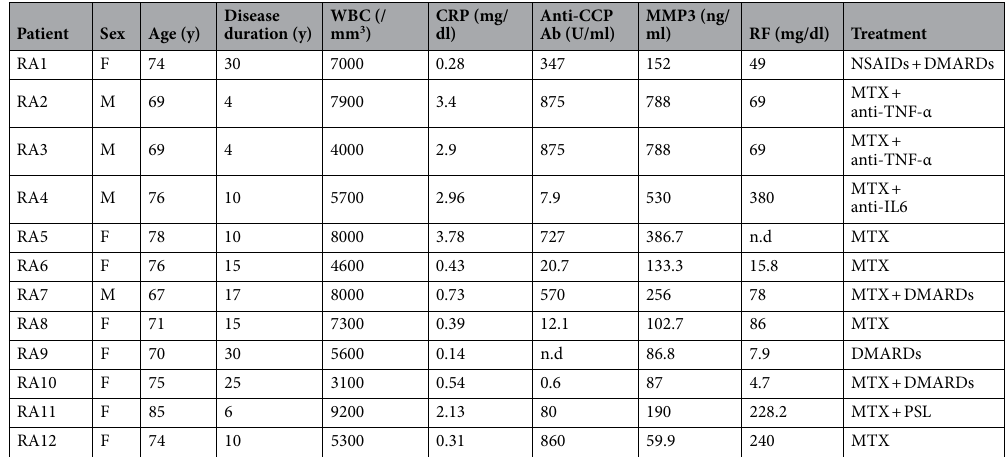
Table 3. Characteristics of patients with RA. anti-CCP Ab anti-cyclic citrullinated peptide antibody, anti-IL6 anti-interleukin 6 antibody therapy, anti-TNF-α anti-tumor necrosis factor-α antibody therapy, CRP C-reactive protein, DMARDs disease modifying antirheumatic drugs, F female, M male, MMP3 matrix metalloproteinase 3, MTX methotrexate, n.d not done, NSAIDs non-steroidal anti-inflammatory drugs, PSL prednisolone, RA rheumatoid arthritis, RF rheumatoid factor, WBC white blood